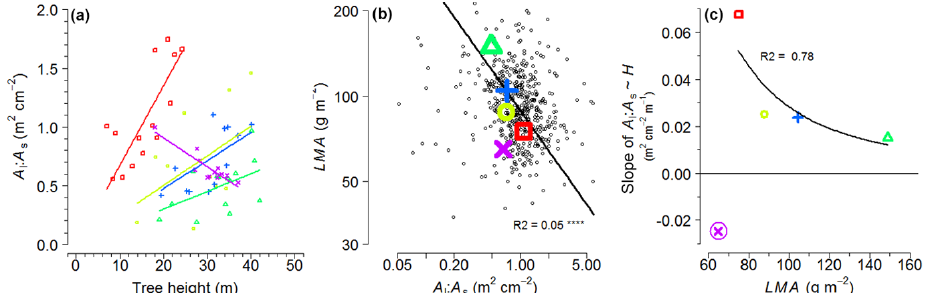
Figure 6. Tropical synthesis showing the dual dependency of the leaf:sapwood area ratio ( A l : A s ) on both leaf mass per area (LMA) and tree height ( H) . (a) A l : A s vs. tree height, replotted from Calvo-Alvarado et al. (2008). (b) Species-averaged LMA vs. A l : A s from panel (a) overlain on a much broader dataset from the Amazon basin (replotted from Patiño et al., 2012). (c) The slope of the A l : A s – H relationship in panel (a) vs. LMA. Circled datapoint is Pentaclethra macroloba , a compound-leaf species averaging 1600 leaflets/leaf and is excluded from the regression. The dependency of A l : A s on LMA in panel (b) is thus implemented in the model via variations in the slope of A l : A s with H in panel (c) ; see Fig. 7g. Asterisk codes for significance are the same as in Fig. 2.